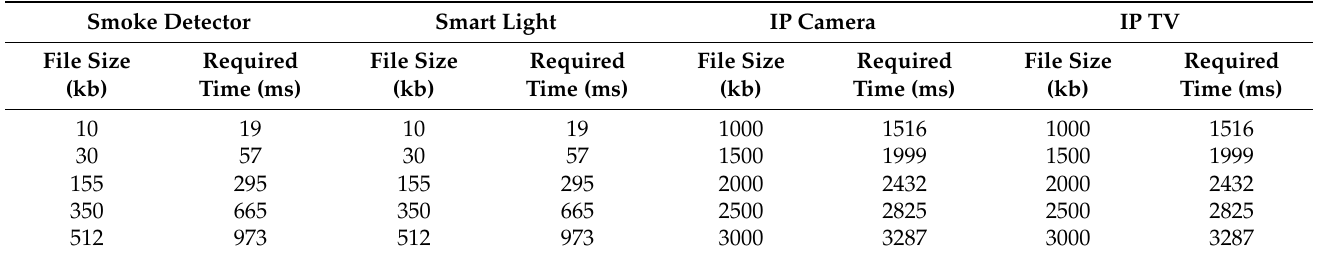
Table 2. Required time for key generation using 3-dimensional key generation matrix (3DKGM) [6]. File sizes are shown in kilobit (kb) and required time is shown in millisecond (ms). For the smoke detector and smart light, the same file sizes are used, while the same file sizes are used for the IP Camera and IP TV.